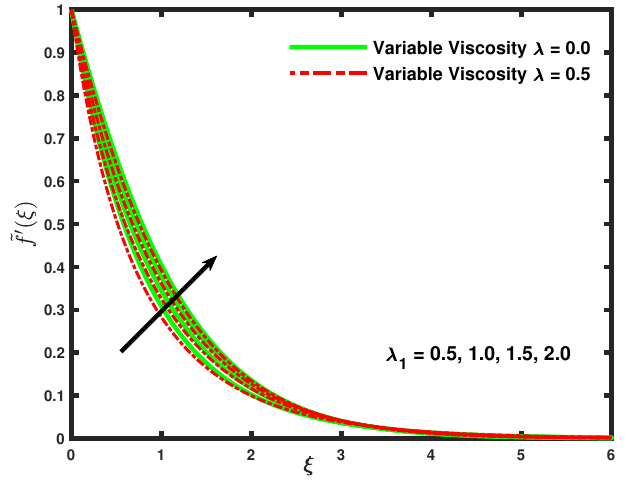
Figure 12. The influence of the Buoyancy parameter ( λ 1 ) on the Velocity profile.